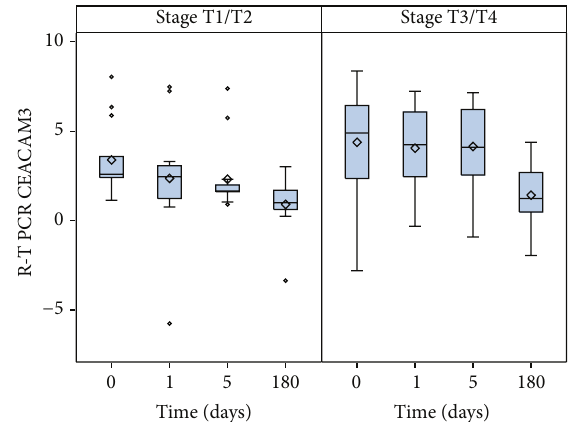
Figure 2: Decreasing trend of CEACAM3 from perioperative to early and late postoperative blood samples according to the pT